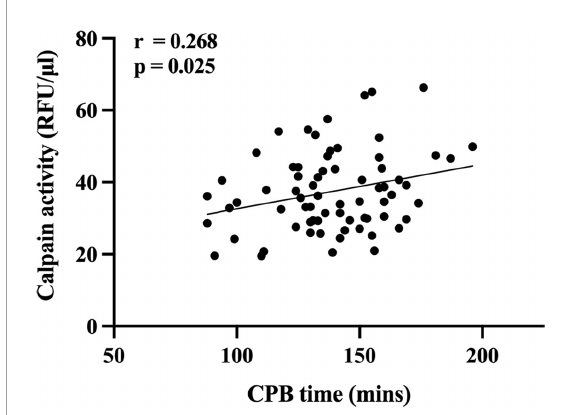
FIGURE2 Scatterplot displaying the relation between cardiopulmonary bypass (CPB) time and serum level of calpains 1 h after CPB.